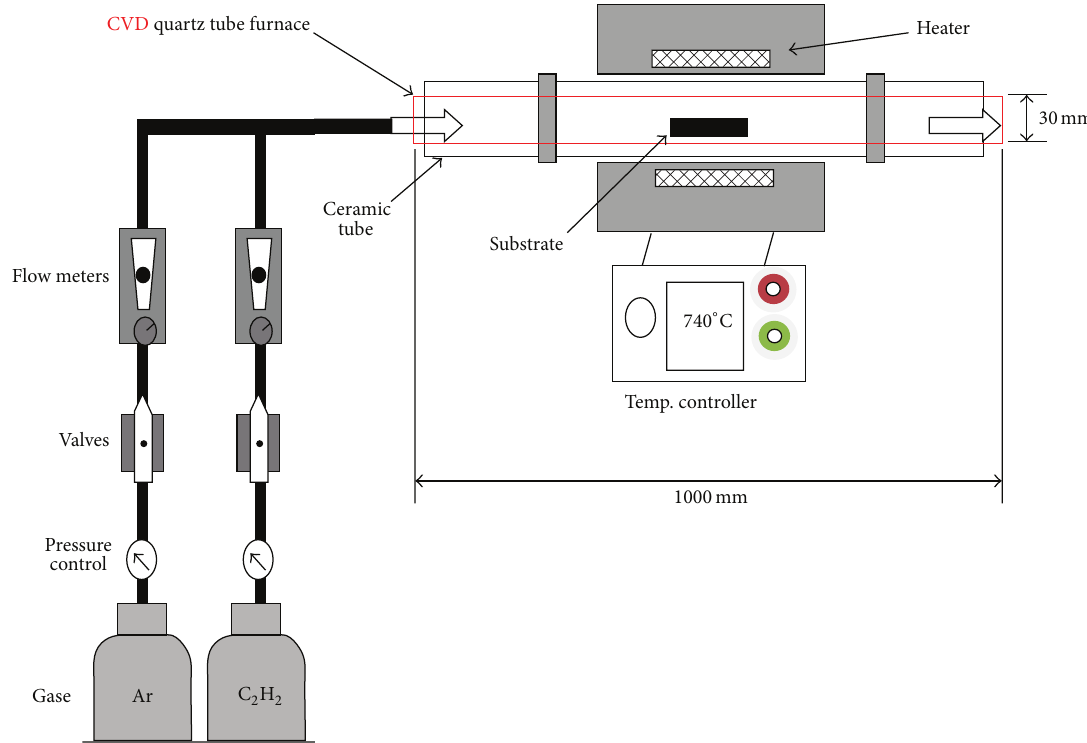
Figure 1: Schematic diagram of the CCVD system.